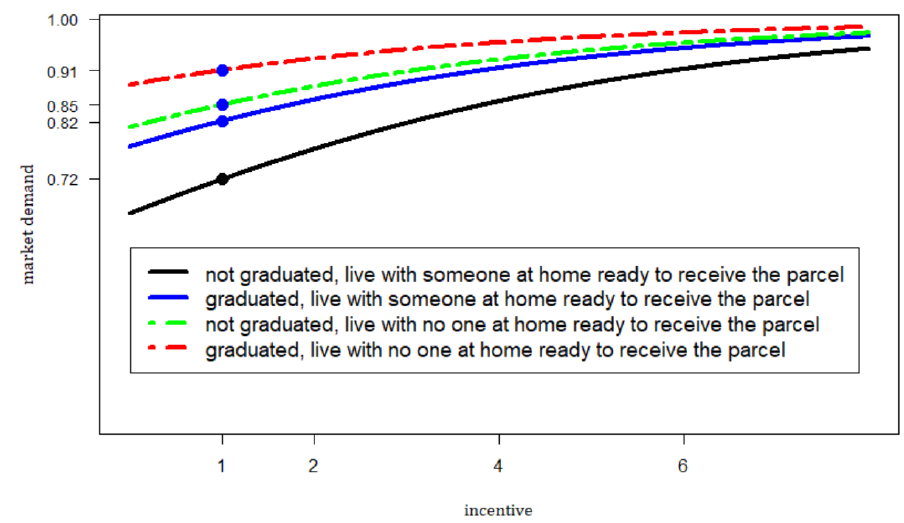
Figure 4. Scenario III–base scenario with 500 m distance and h24 accessibility.